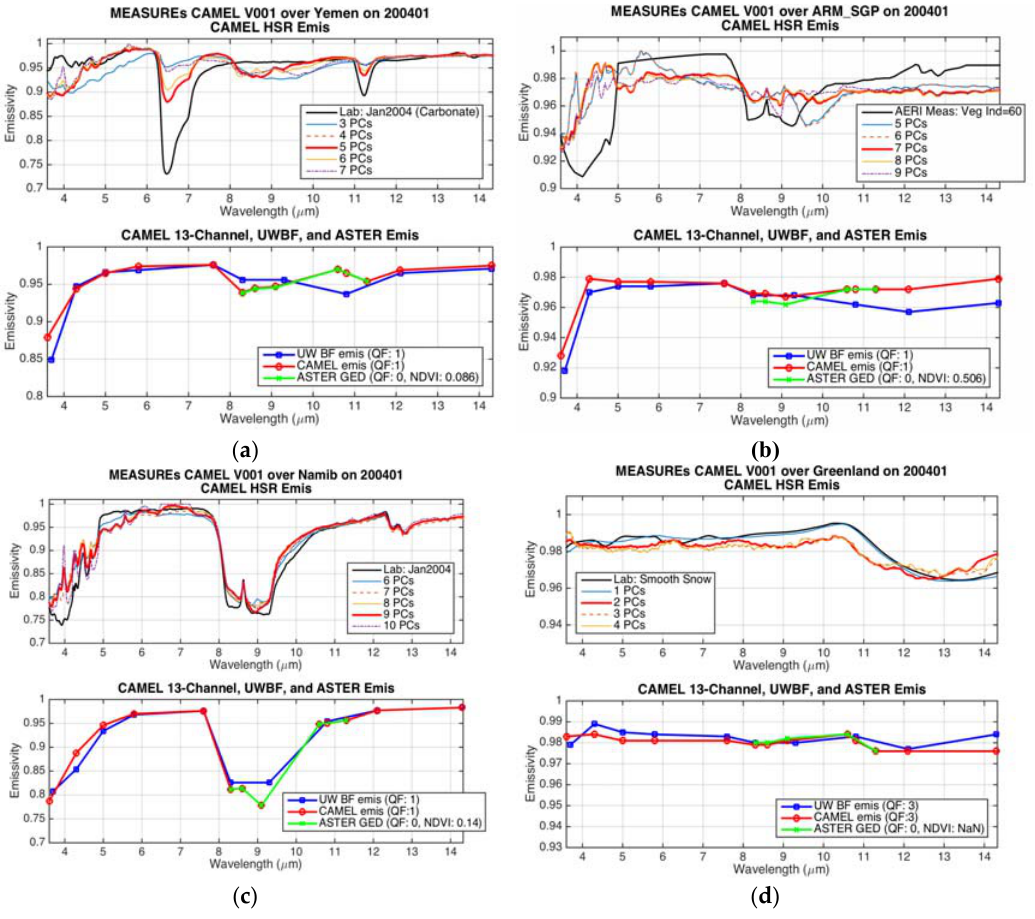
Figure 10. Emissivity on January 2004 at ( a ) Yemen, ( b ) Atmospheric Radiation Measurement (ARM) Southern Great Plains (SGP) Cart site, ( c ) Namib Desert, and ( d ) Greenland case sites. High spectral resolution emissivity from CAMEL with a different number of PCs used (different colored lines) and lab or Atmospheric Emitted Radiance Interferometer (AERI) measurements (black) are shown in the top row panels. The selected number of PCs is solid red for each case.